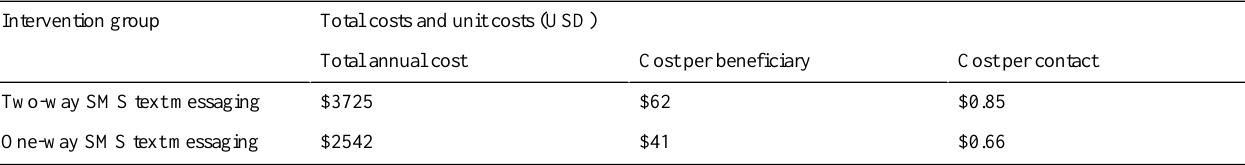
Table 3. Weighted average total annual incremental costs and unit costs for beneficiaries.